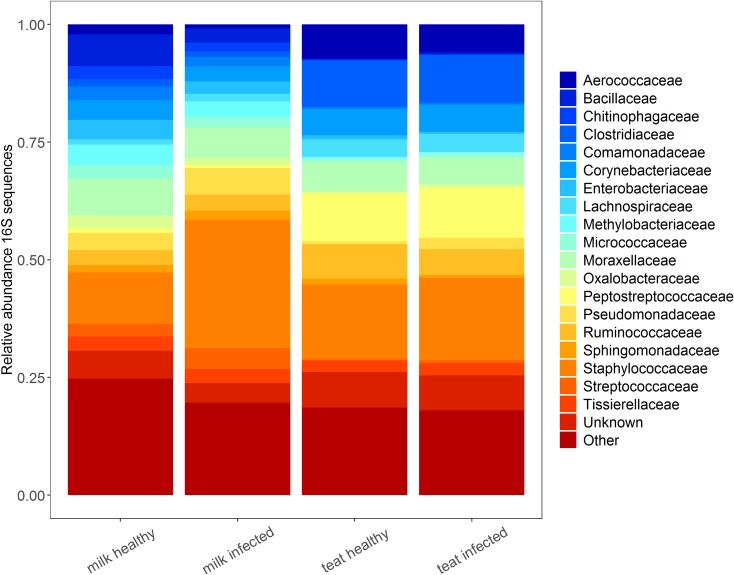
Twenty most relatively abundant categories of 16S rRNA gene sequence OTUs as arranged by bacterial family in each habitat state.“Unknown” category denotes unique OTUs that are unable to be classified at the family level, or potentially only as bacteria. “Other” category denotes those families that are not among the 20 most relatively abundant.